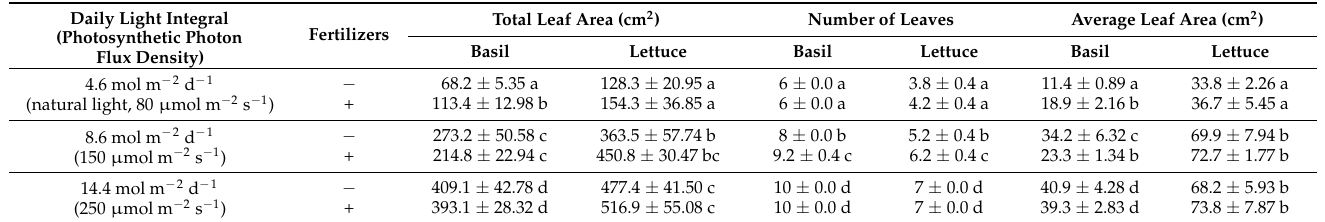
Table 1. The effect of light intensity and fertilization on the morphological parameters of basil and lettuce. Values are mean ± SE of 5 replicates, and values with different letters in columns differed significantly according to Tukey multiple comparison test ( p ≤ 0.05).